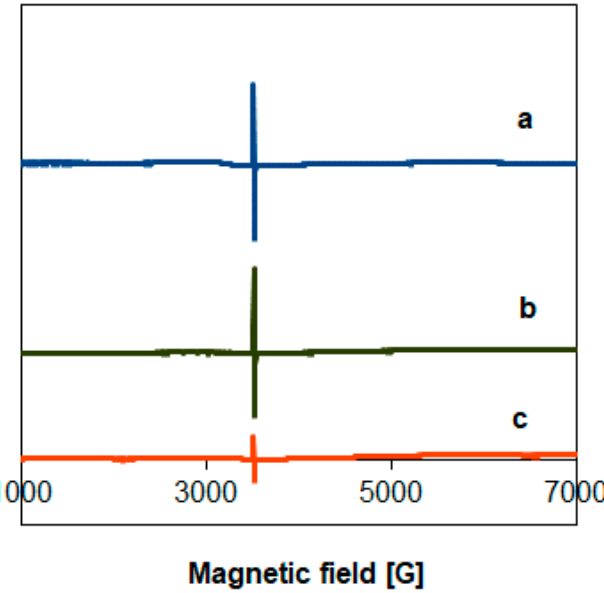
Figure 8. Effect of the co-catalyst forming by calcination in sol–gel-prepared samples on the ESR spectra. ( a ) SG400; ( b ) SG400PtCalc, ( c ) blank SG400 sample re-calcined at 400 °C.